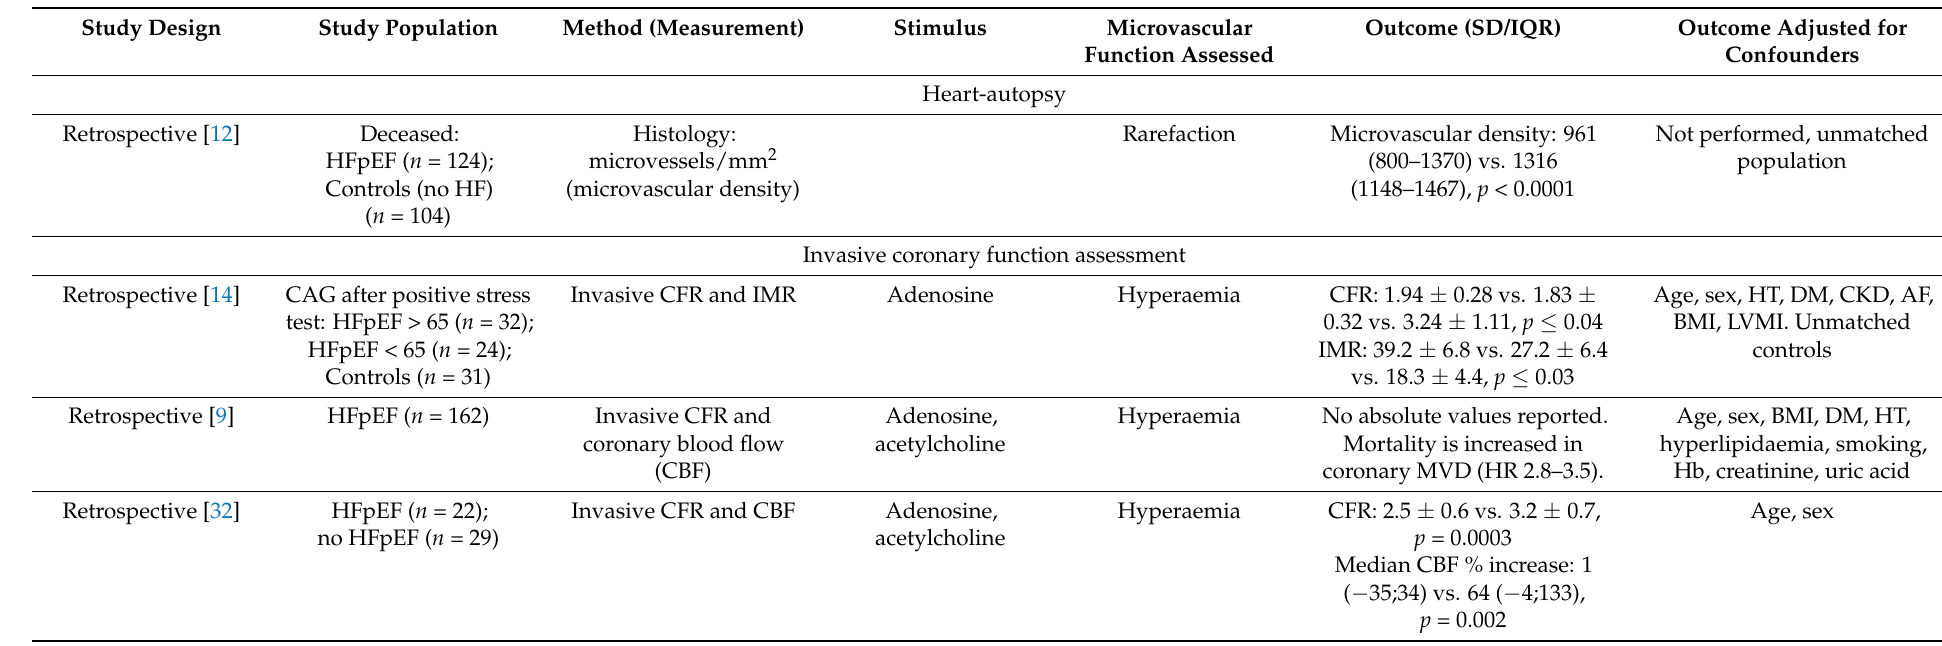
Table 2. Studies on coronary microvascular function in